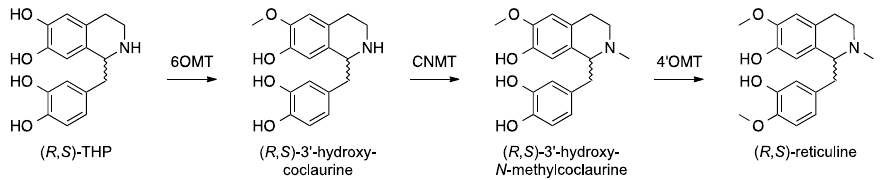
Figure 12. Heterologous biosynthetic pathway constructed in yeast ( Saccharomyces cerevisiae ) for the production of ( R , S )-reticuline from the exogenously provided substrate, ( R , S )-tetrahydropapaveroline (THP, also known as norlaudanosoline) [71]. 6OMT, norcoclaurine 6- O -methyltransferase; CNMT, coclaurine N -methyltransferase; 4 (cid:48) OMT, 3 (cid:48) -hydroxy- N -methylcoclaurine 4 (cid:48) - O -methyltransferase.